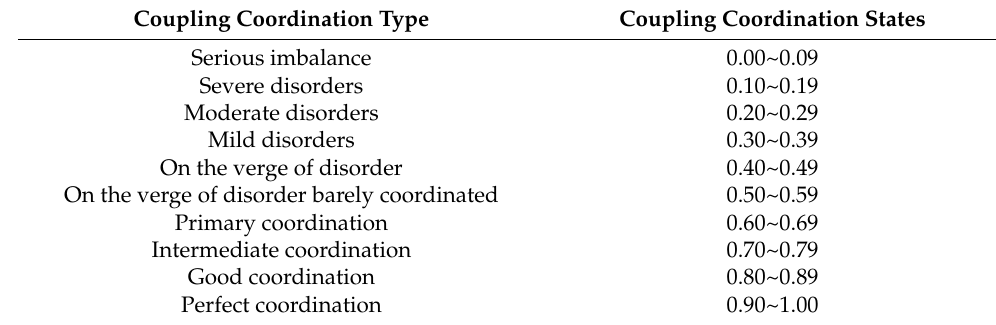
Table 3. Classification criteria for the level of coupling coordination between mixed land use and urban